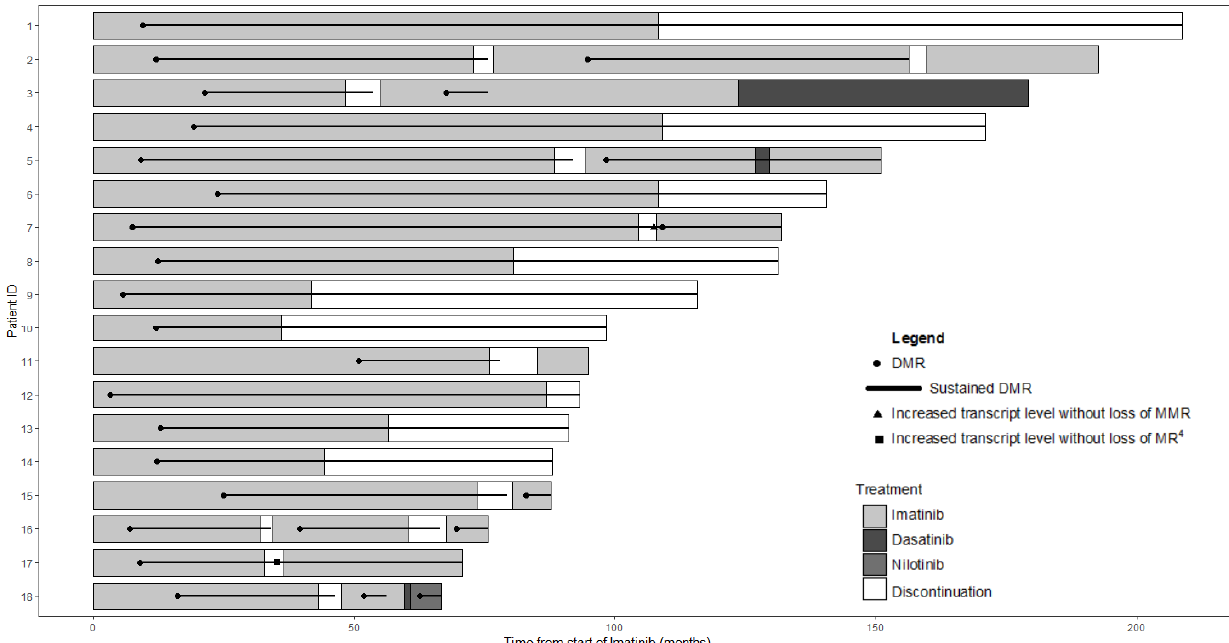
Figure 1. Swimmer plot depicting treatment course of each patient according to the time from the start of imatinib. Each band represents an individual patient. The bands are color-coded based on the patients’ treatment. In each band, a black line indicates periods of sustained deep molecule response (DMR). Patients 3 and 18 were switched to second-generation tyrosine kinase inhibitors because of unstable DMR after imatinib resumption. Dasatinib was introduced in patient 5 in order to optimize the DMR but was quickly stopped because of side effects. MMR, major molecular response; MR 4 , ratio BCR-ABL1/ABL1 of 0.01%.